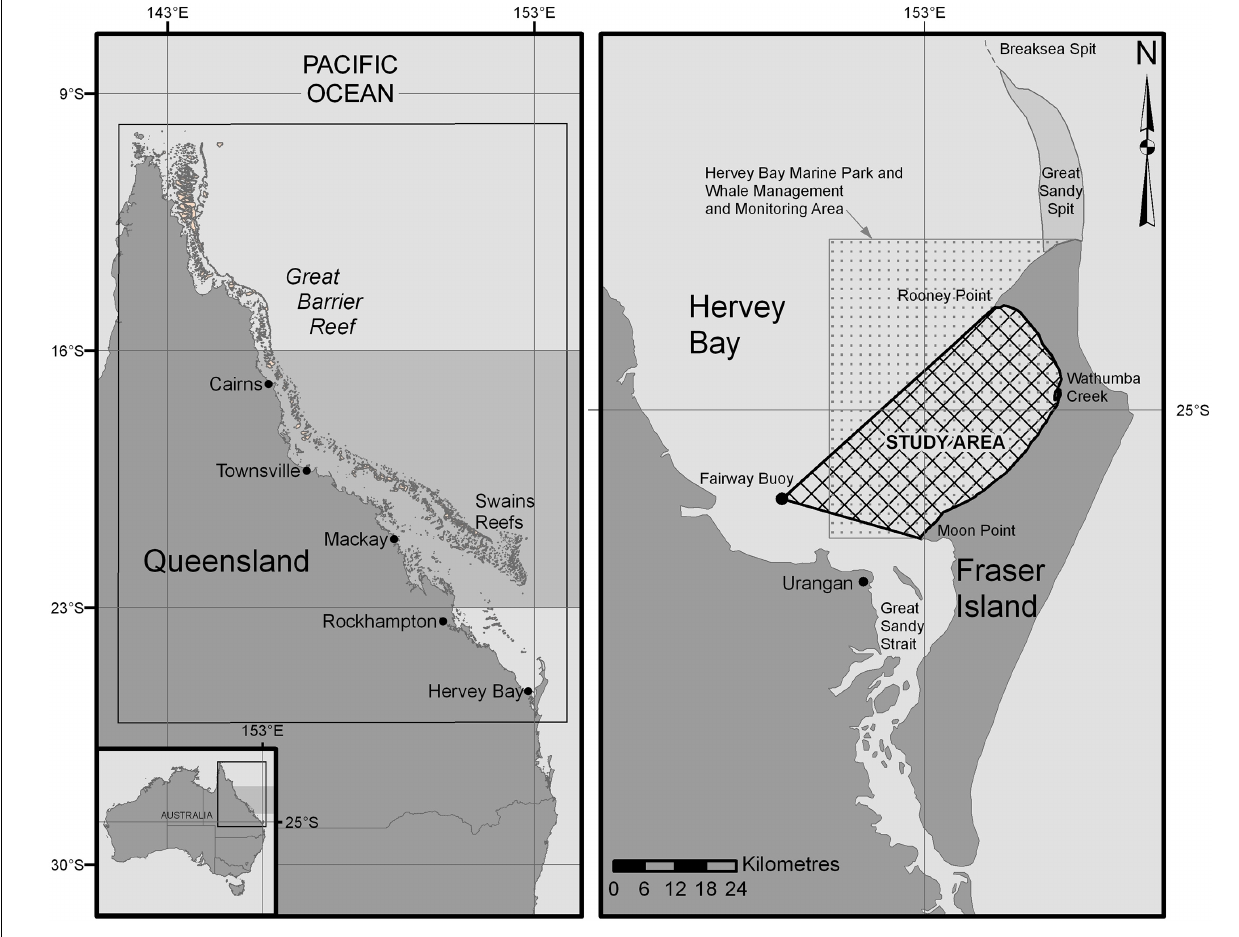
Frontiers in Marine Science |